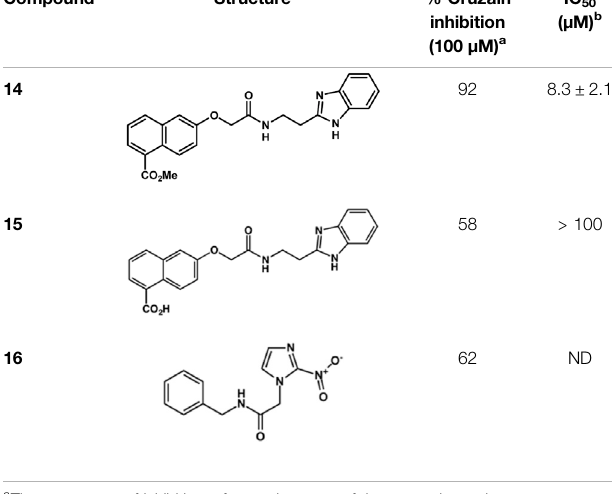
TABLE 2 | Structure and activity against cruzain of new benzimidazoles with substituents at the phenyl ring. a Compound Structure